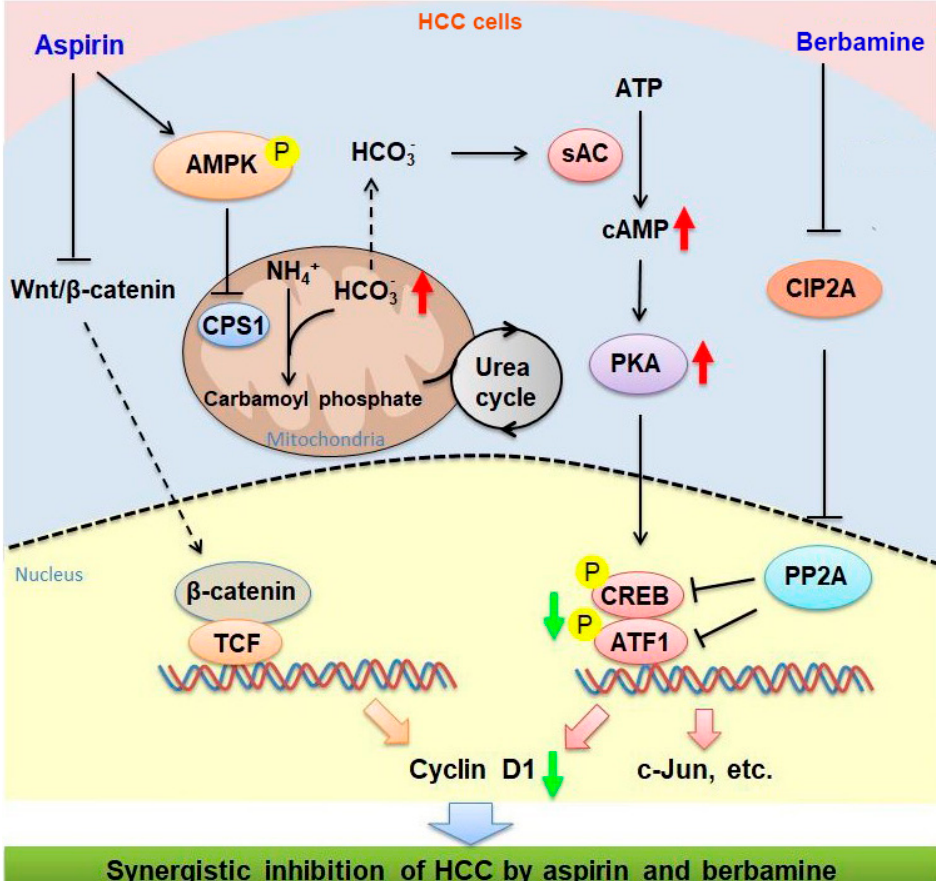
Figure 8. Schematic illustration of the signaling pathways that are involved in the synergistic inhibition of HCC by aspirin and berbamine. While aspirin may inhibit Wnt/ β -catenin signaling, it can activate AMPK, leading to downregulation of CPS1 in HCC cells. Downregulation of CPS1 diverts bicarbonate to stimulate sAC, thereby increasing cAMP synthesis, which may contribute, at least in part, to the stimulation of PKA activation and CREB/ATF1 phosphorylation in HCC cells by aspirin. Berbamine can inhibit CIP2A expression in HCC cells, leading to PP2A-dependent abrogation of aspirin-induced CREB/ATF1 phosphorylation and target gene expression. Thus, the combination of aspirin and berbamine can synergistically inhibit HCC. Red arrows represent the upregulation of indicated molecules by aspirin. Green arrows represent the net effects of combined treatment with aspirin and berbamine on indicated proteins.